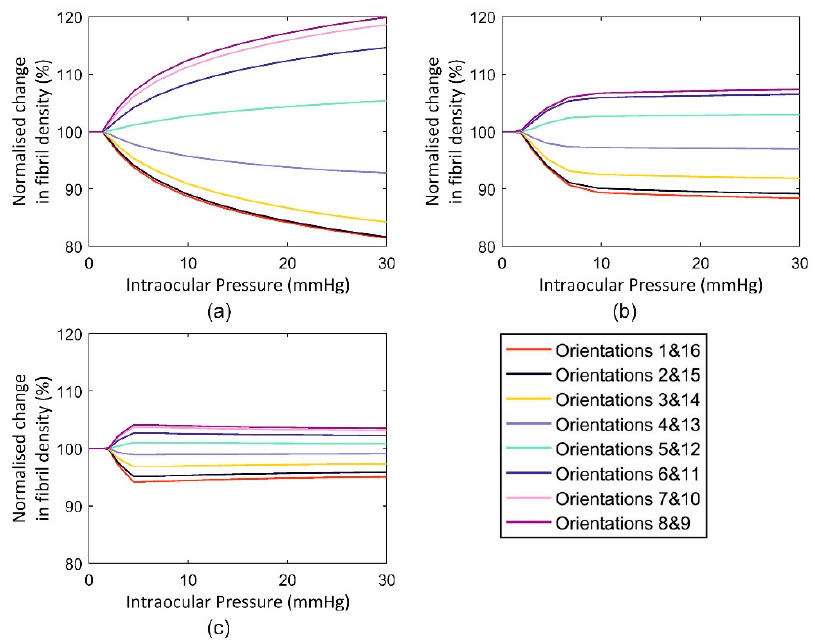
Figure 12. Fibril reorientation in an inflated ocular model with central corneal region removed under intraocular pressure up to 30 mmHg at three locations across the cornea including ( a ) element 1, ( b ) element 2 and ( c ) element 3.